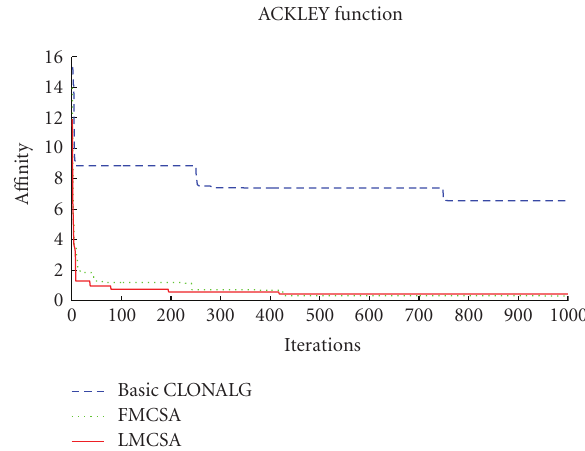
Figure 11: Convergent performances on Ackley’s function ( f